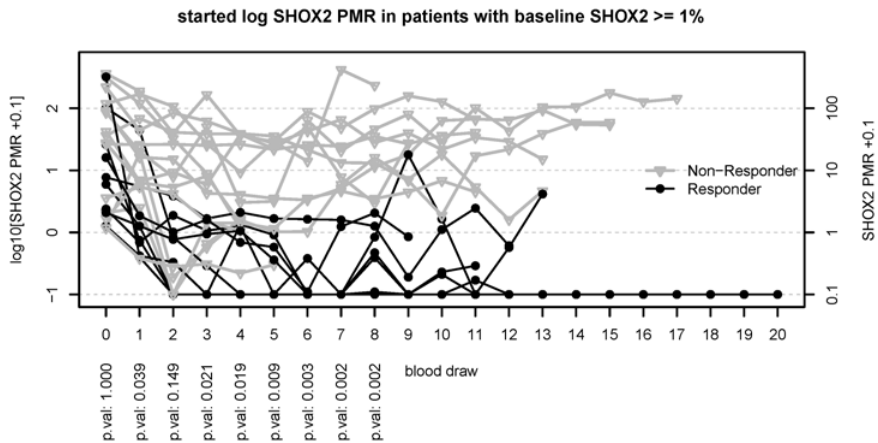
Fig 1. Trend curves for patients responding (black curves) and not responding (gray curves) to the therapy. The patients included in this figure are limited to the ones with a baseline mSHOX2 value of at least 1% PMR. The first blood draw (x = 0) is the point of diagnosis, i.e. before treatment and defines the baseline methylation of SHOX2. For the first eight blood draws Bonferroni corrected p-values from unpaired two sample Wilcox tests are given at the bottom.